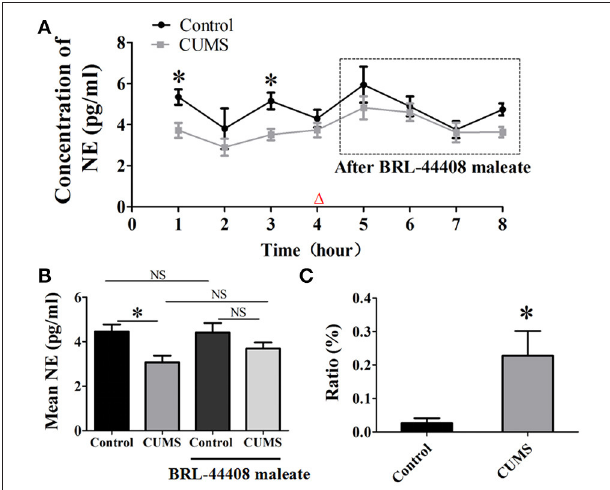
FIGURE 3 | Intraperitoneal injection of BRL-44408 maleate can reverse the decrease of NE release induced by CUMS. (A) The dialysate concentration of NE were less in the first and third hour in the CUMS rats than that in the control rats, intraperitoneal injection of BRL-44408 maleate increased extracellular level of NE in both group of rats, but no significance was observed between the two groups. (B) The CUMS significantly decreased the mean levels of extracellular NE in the PVN of the CUMS rats compared to that in the control rats, but no significance was observed between the two groups after BRL-44408 maleate. (C) The ratio of increase in the NE release was significantly amplified after administration of BRL-44408 maleate in the CUMS rats compared to that in the control rats. The ratio: [(after-before)/before BRL-44408 maleate]. 1 : BRL-44408 maleate administration (3 mg/kg, i.p.). * p < 0.05 vs. the control rats. NS represents no significance.